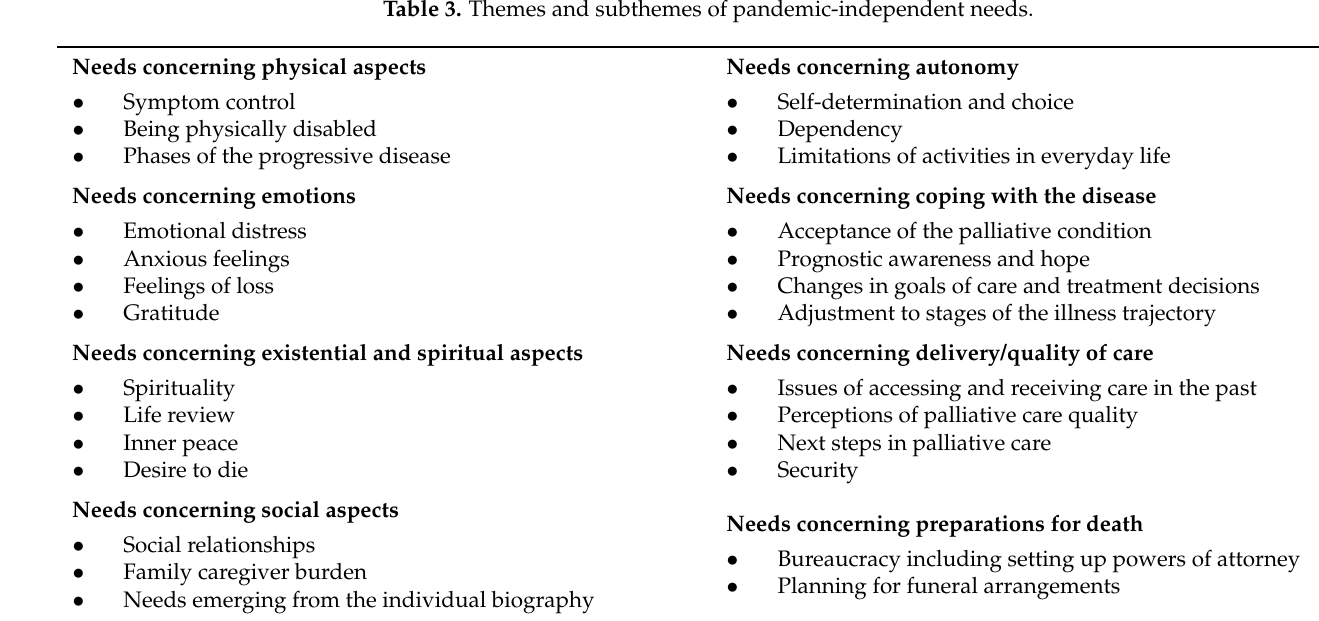
Table 3. Themes and subthemes of pandemic-independent needs.